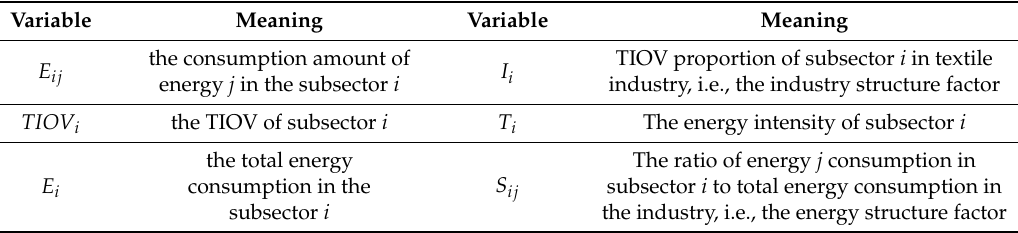
Table 2. Meanings of the decomposition analysis model